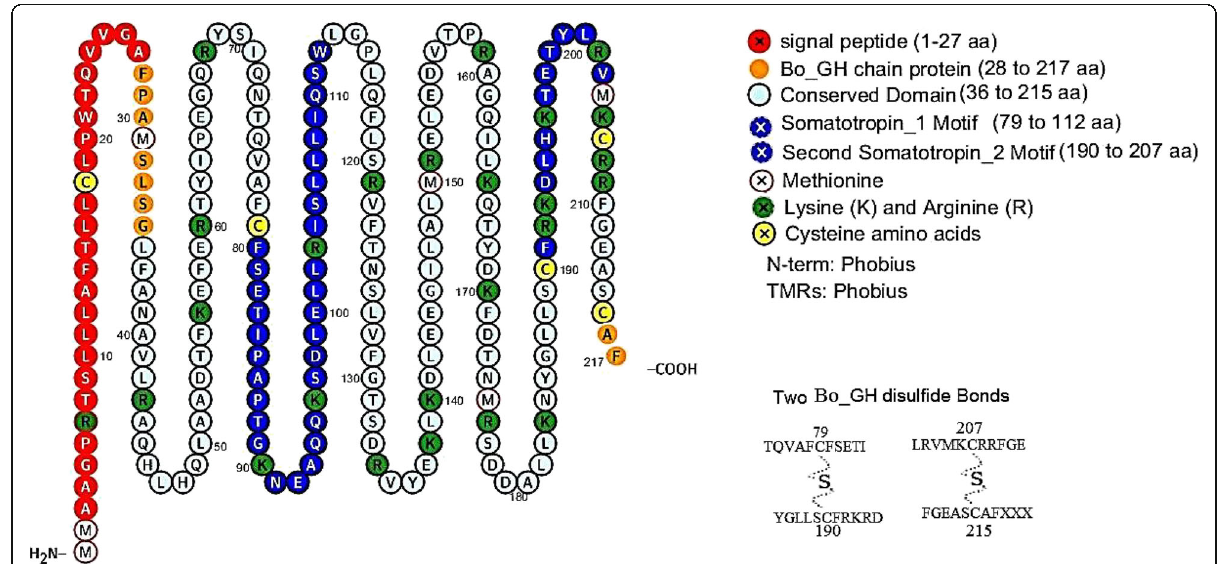
Fig. 17 The Boer goat GH_cDNA protein features and disulfide